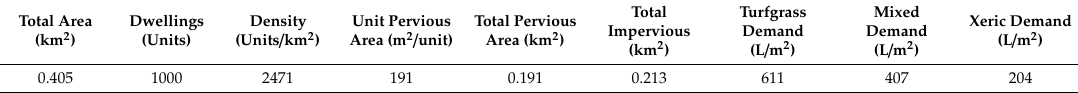
Table 4. Land use and seasonal water demand metrics for example development.